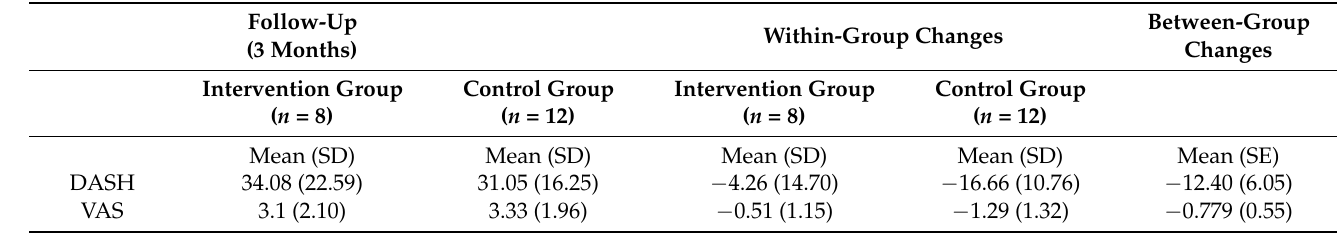
Table 3. Follow-up results of primary outcome measures including within-group and between-group changes.